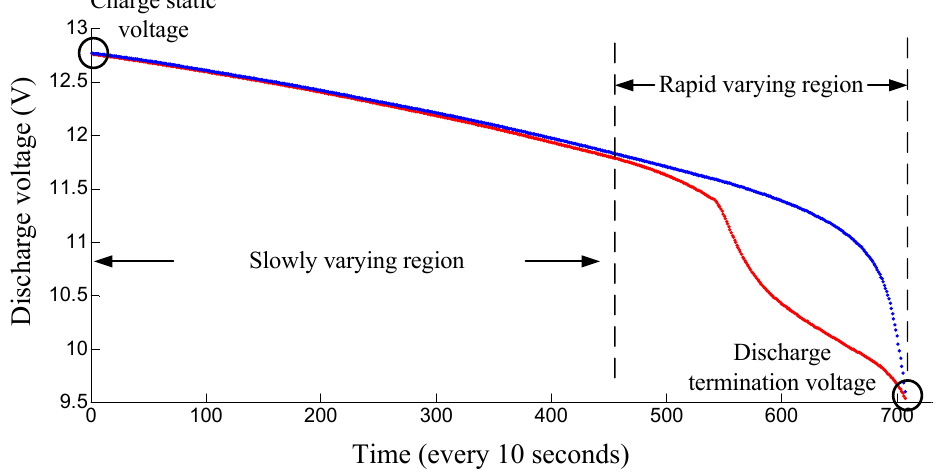
Figure 3. Discharging curves of different